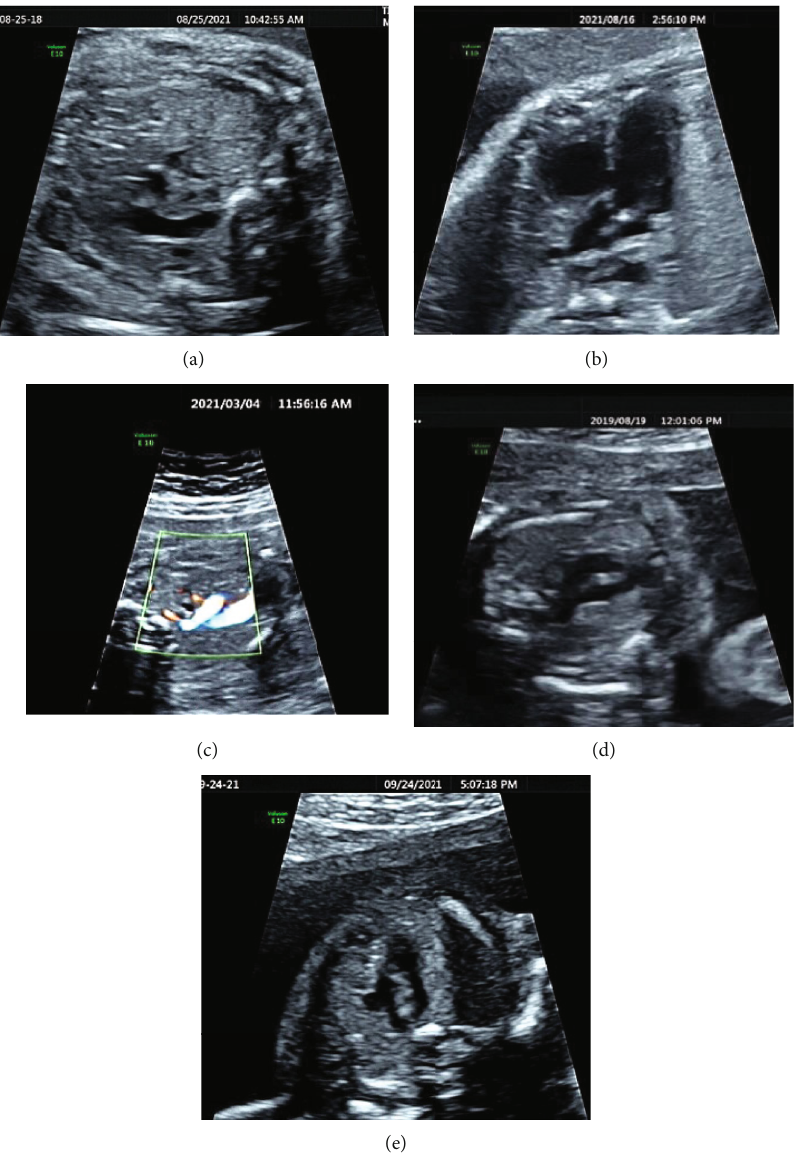
Figure 5: Ultrasonic images of fetus with abnormal heart. (a) Persistent left superior vena cava. (b) Ventricular septal defect. (c) Abnormal right subclavian artery. (d) Pulmonary artery stenosis. (e) dextroaortic arch.